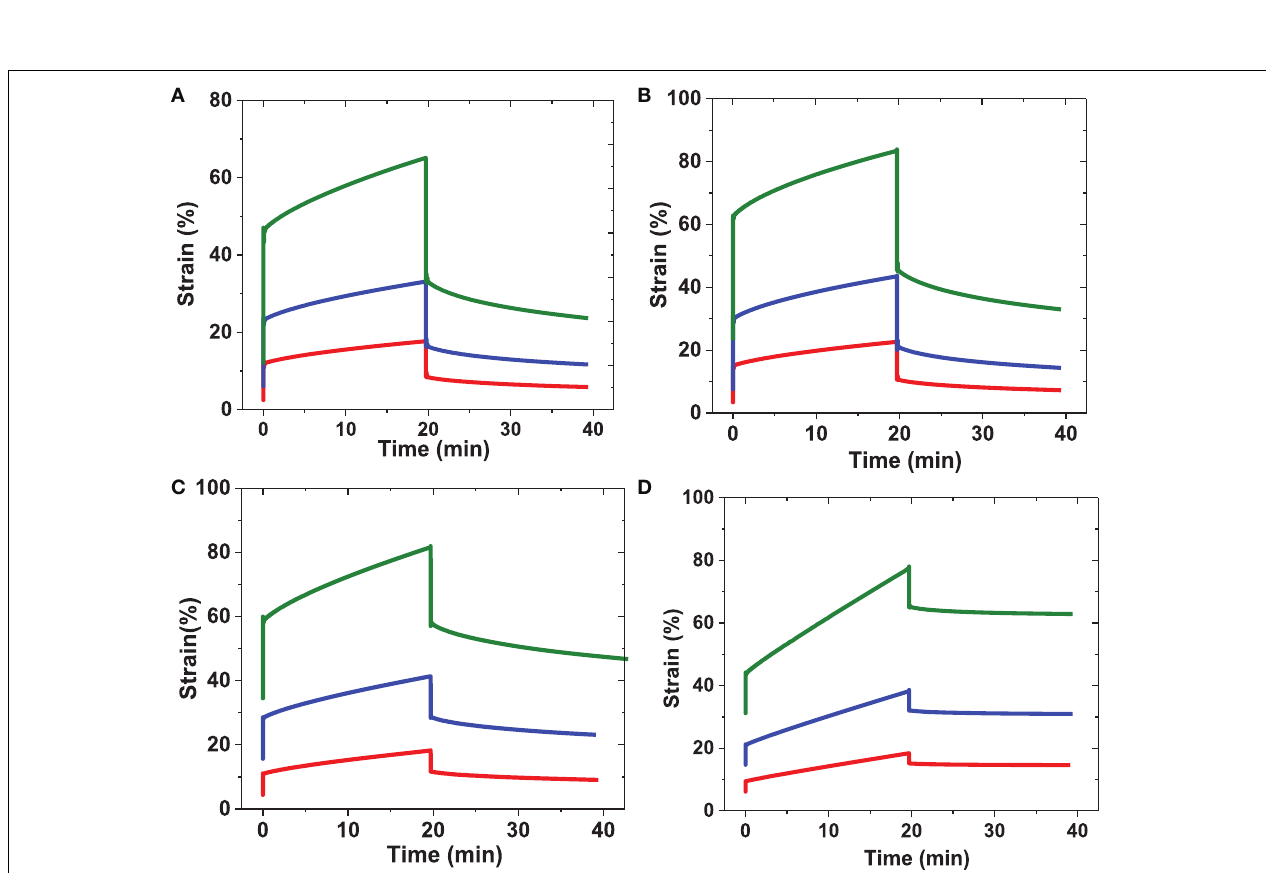
FIGURE 7 | Representative creep behavior for RLP and PEG hydrogels. Samples were subjected to applied constant shear stresses for 20min followed by removing the applied shear stresses and monitoring strain change over another 20min. (A) 5 wt% RLP at constant shear stress 100 Pa(red), 200 Pa(blue), and 500 Pa(green);